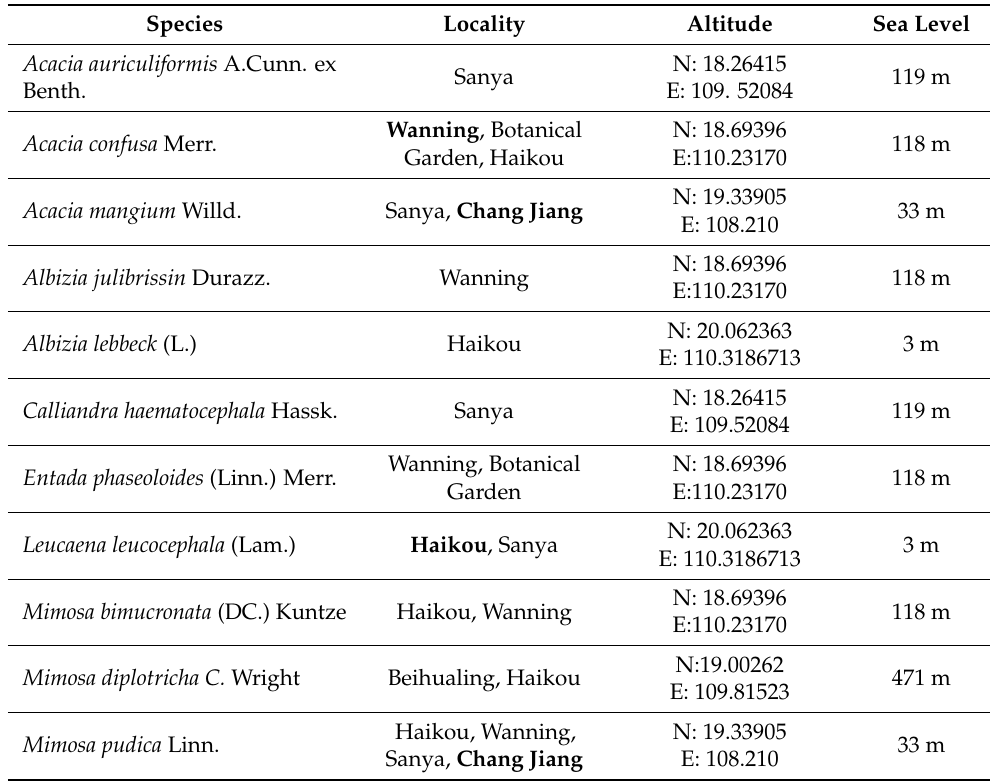
Table 1. List of Mimosoideae taxa collected from different geographical regions on Hainan Island. Species Locality Altitude Sea Level Acacia auriculiformis A.Cunn. ex